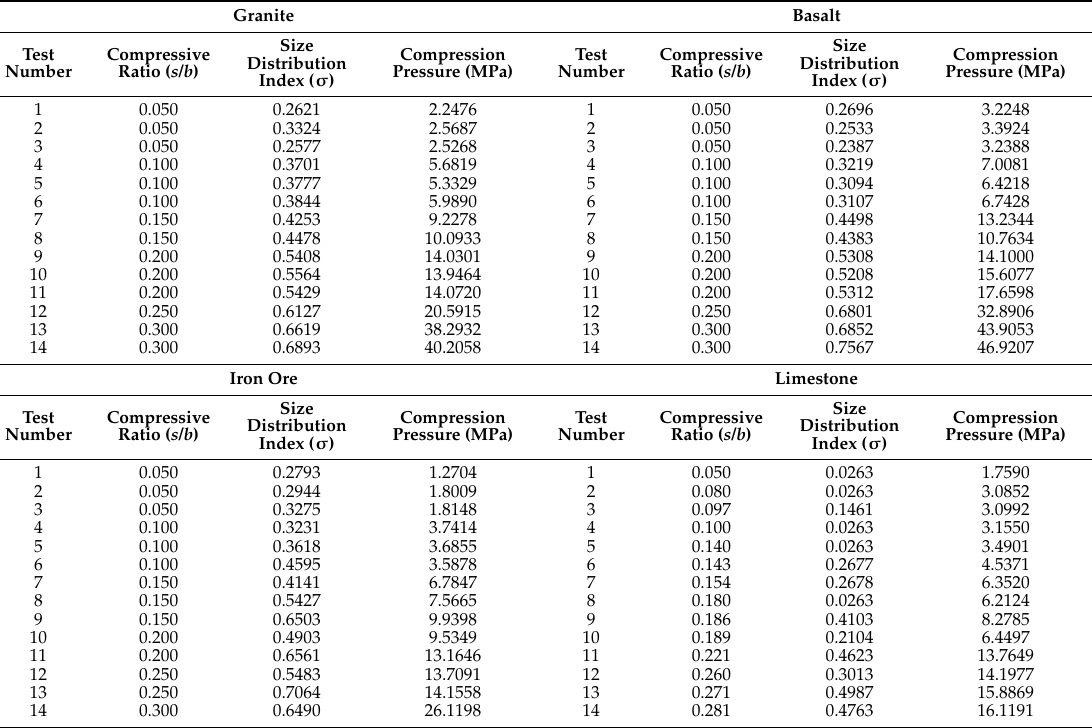
Table 1. Results of crushing experiments.